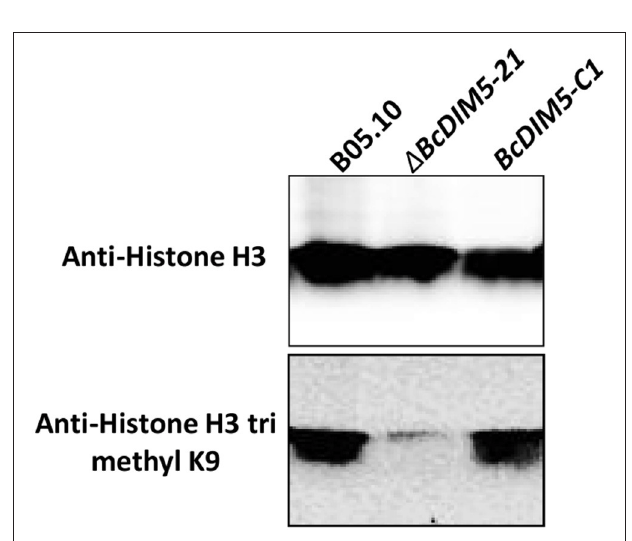
FIGURE 5 | Western-blot analysis of B. cinerea using antibodies histone H3 or trimethylated H3K9. In each case, 100 µ g total proteins from wild-type B05.10, ∆ BcDIM5-21, or BcDIM5-C1 strains were fractionated by SDS–PAGE (12%) and analyzed using the indicated antibodies. The monoclonal anti-Histone H3 was used as internal loading